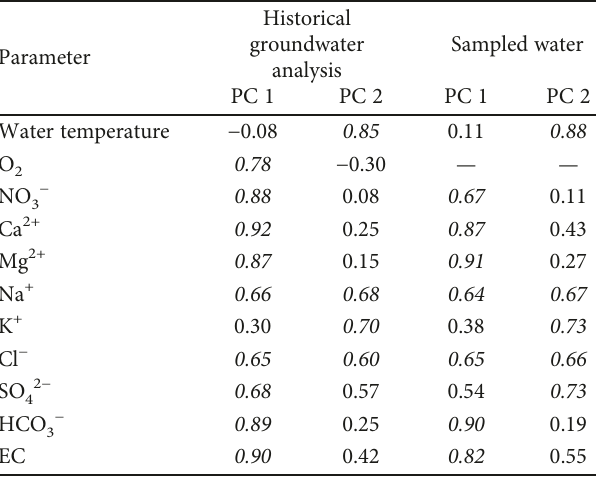
Table 2: Results of PCA (signi fi cant loadings are marked in italics). Parameter